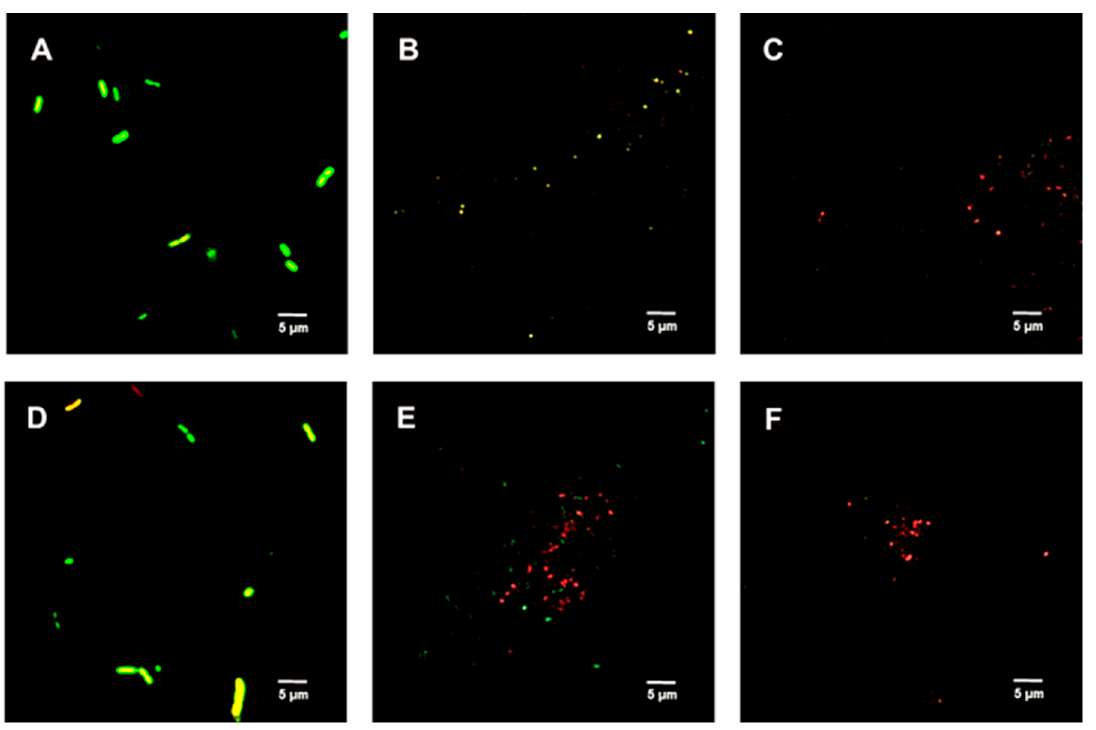
Figure 5. Live/Dead assay of Bacillus spp. spores with TFDG at 60-min incubation. The green indicates viable spores, while the red indicates non-viable spores. ( A ) B. cereus spores control; ( B ) B. cereus spores with 312.5 µg/mL TFDG; ( C ) B. cereus spores with 625 µg/mL TFDG; ( D ) B. subtilis spores control; ( E ) B. subtilis spores with 312.5 µg/mL TFDG; and ( F ) B. subtilis spores with 625 µg/mL TFDG.